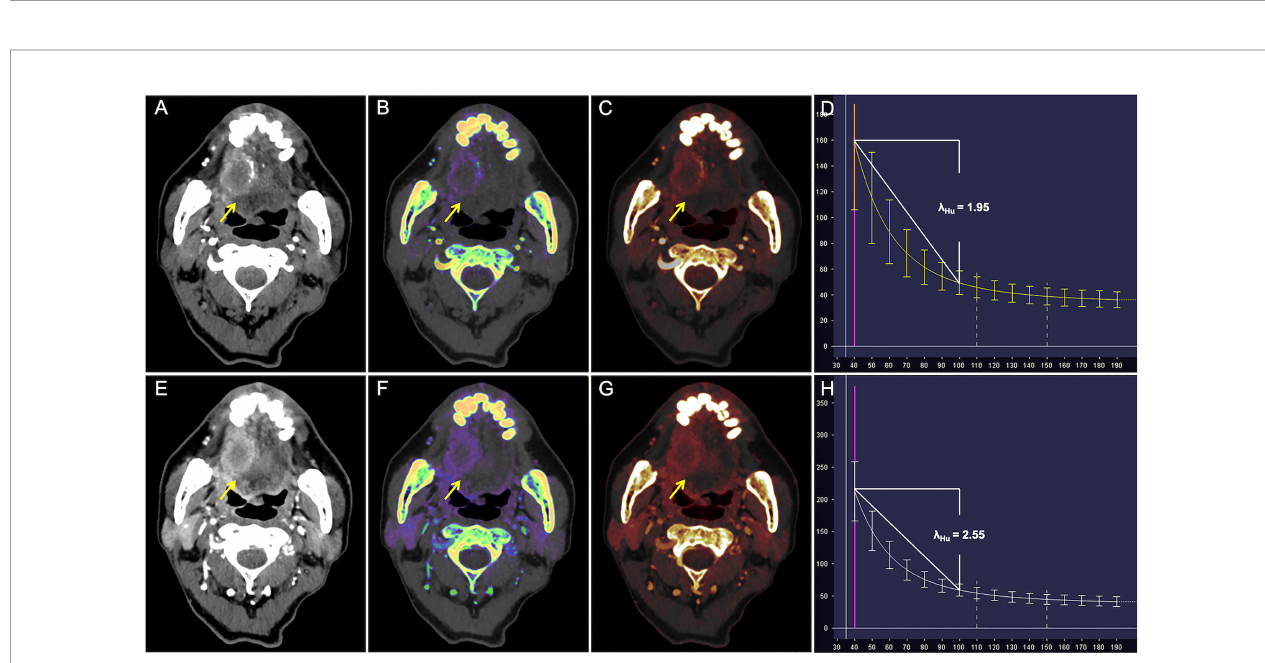
FIGURE 4 | CT Images in a 65-year-old man with poorly differentiated T3N1M0 OTSCC in stage III. (A – D) Arterial phase imaging of the primary tumor (arrow). (A) Contrast-enhanced 40-keV monochromatic image shows lesion with mean CT value of 167.12 HU. (B) Effective atomic number map shows lesion with mean Z eff value of 8.37. (C) Iodine-based pseudo-colorized image shows lesion with mean IC of 1.53 mg/ml. (D) Spectral Houns fi eld unit curve shows lesion with mean l Hu of 1.95 HU/keV. (E – H) Venous phase imaging of the primary tumor (arrow). (E) Contrast-enhanced 40-keV monochromatic image shows lesion with mean CT value of 212.34 HU. (F) Effective atomic number map shows lesion with mean Z eff value of 8.72. (G) Iodine-based pseudo-colorized image shows lesion with mean IC of 2.2 mg/ml. (H) Spectral Houns fi eld unit curve shows lesion with mean l Hu of 2.55 HU/keV.